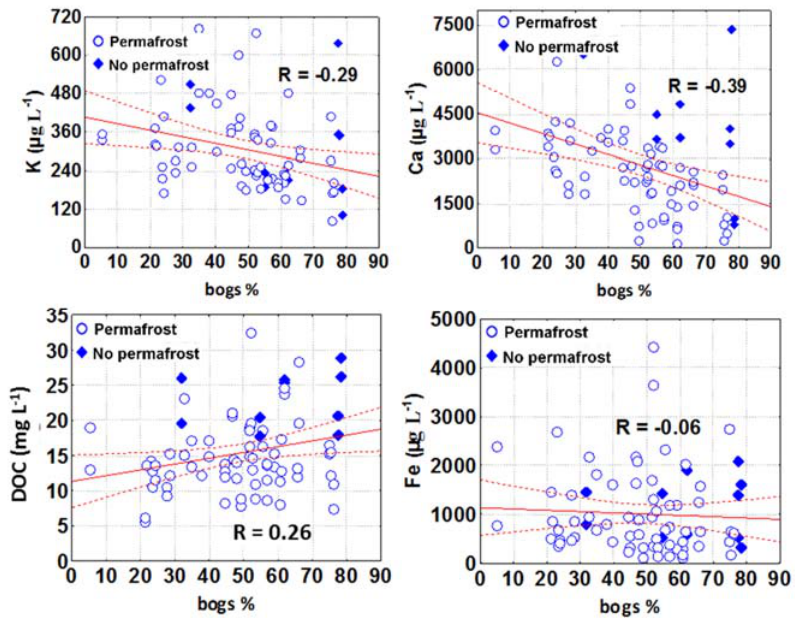
Figure 3. Correlations (R is the Pearson coefficient) between K, Ca, DOC, Fe, and bog proportion on the watershed in permafrost ‐ free (open circles) and permafrost ‐ bearing (closed diamonds) rivers. The two sampling periods, June and August, are combined together. The solid line is for the main trend and the dashed lines are significant at p < 0.05.